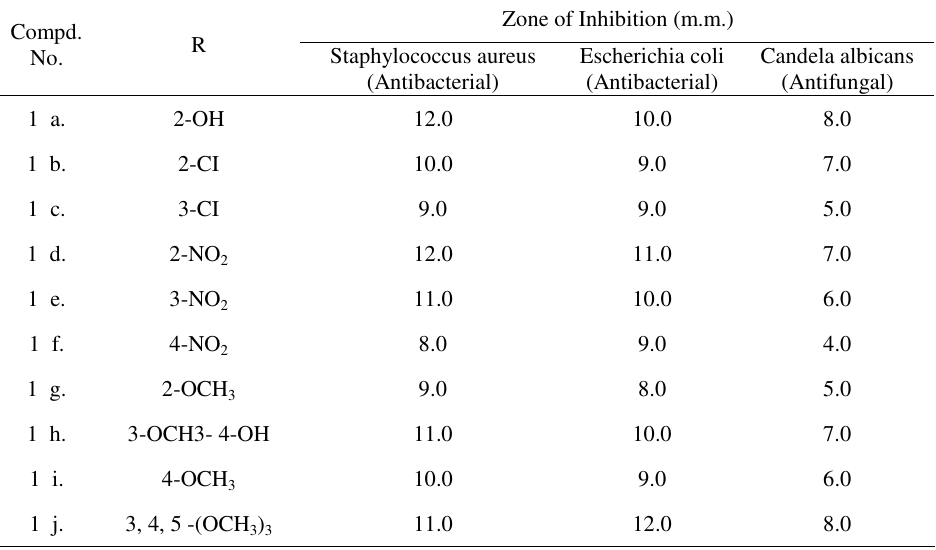
Zone of Inhibition (m.m.)